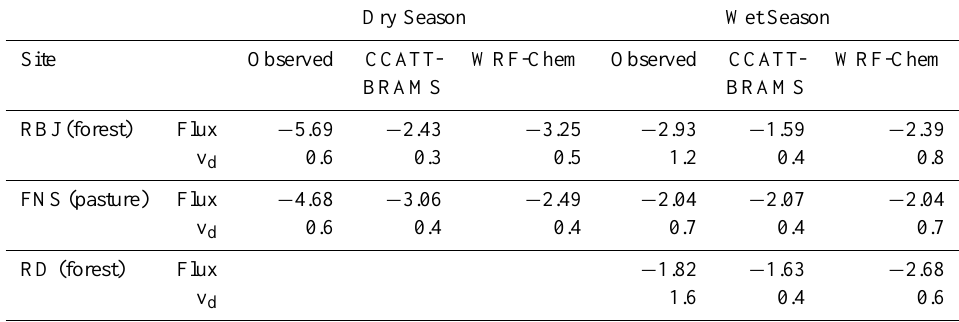
Table 5. Observed average O 3 dry deposition flux (nmolm − 2 s − 1 ) and daytime (11:00–21:00UTC) median deposition velocity (cms − 1 ) in the dry and wet seasons (Rummel et al., 2007), and from WRF-Chem and CCATT-BRAMS simulations from November 2008 (dry-to-wet transition) and May 2009 (wet-to-dry transition) for Reserva Biológica Jarú (RBJ), Fazenda Nossa Senhora (RNS), and Reserva Ducke (RD).